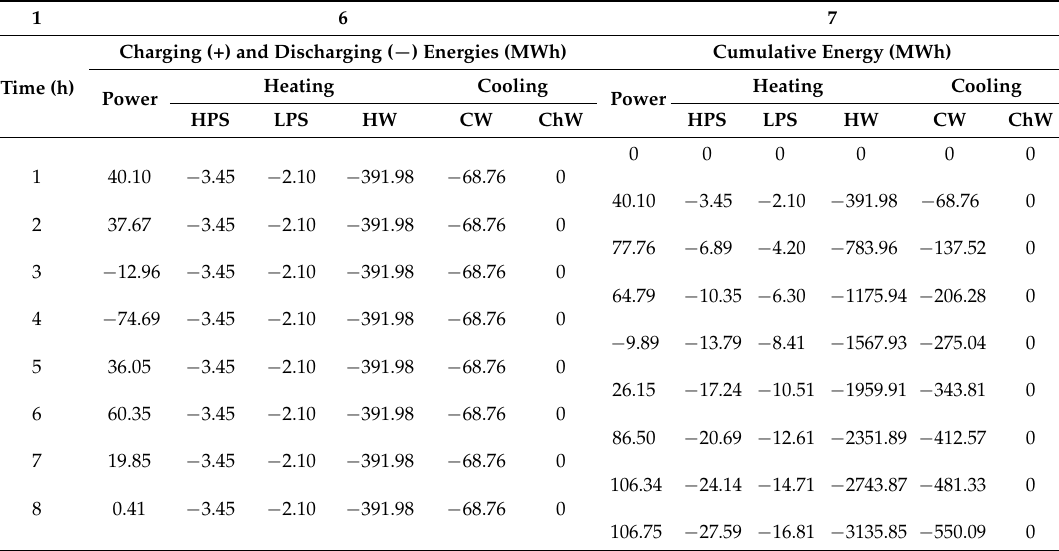
Table A5. TriGenSCA before iteration from time 1 to 12